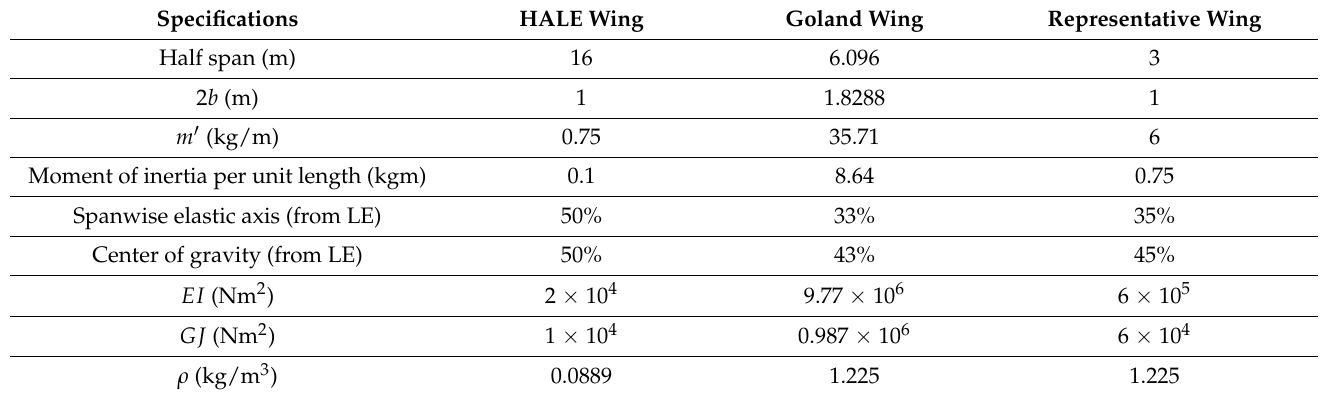
Table 2. Properties of representative wings used for validation “Reprinted from